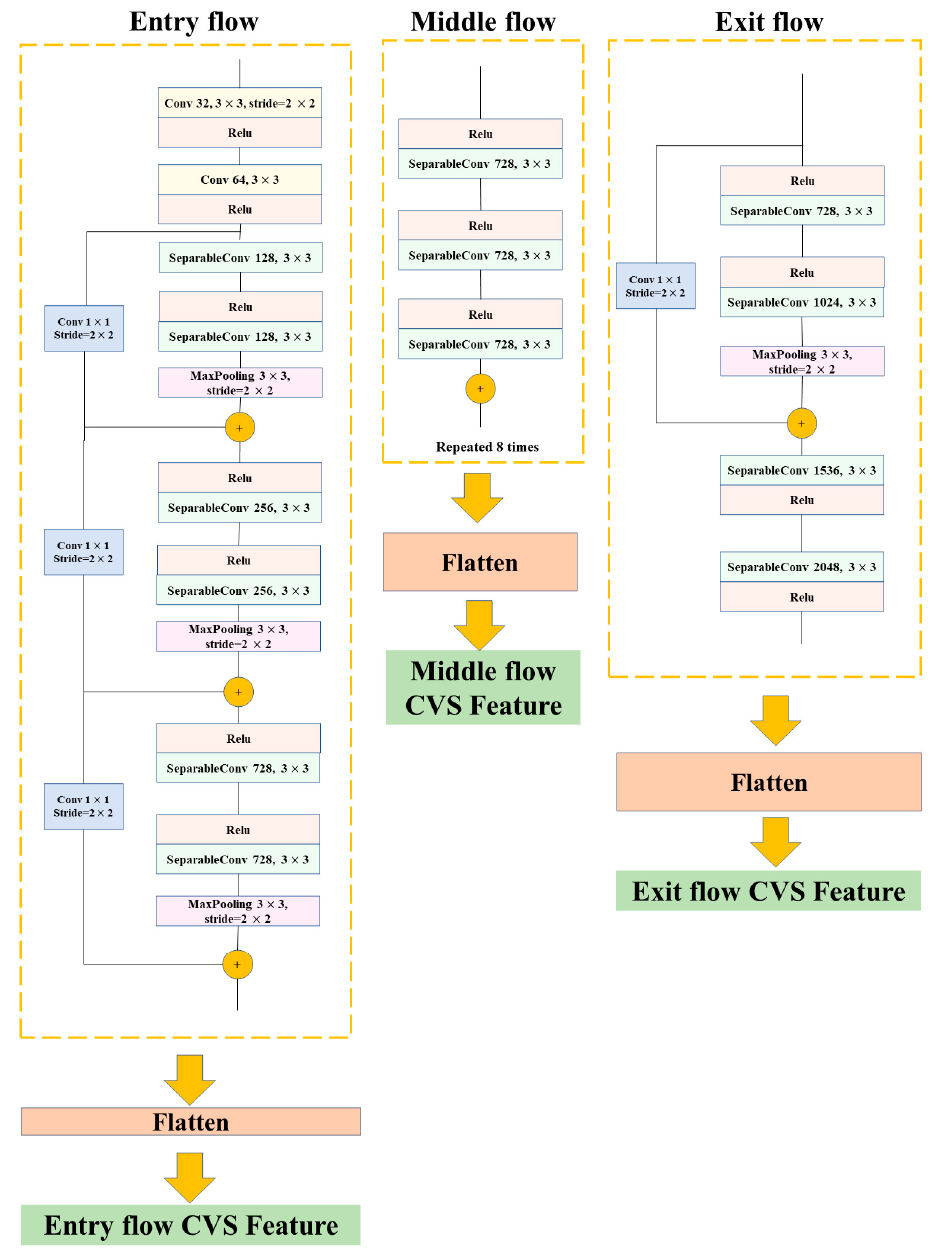
Figure 4. The architecture of the different layers of Xception.